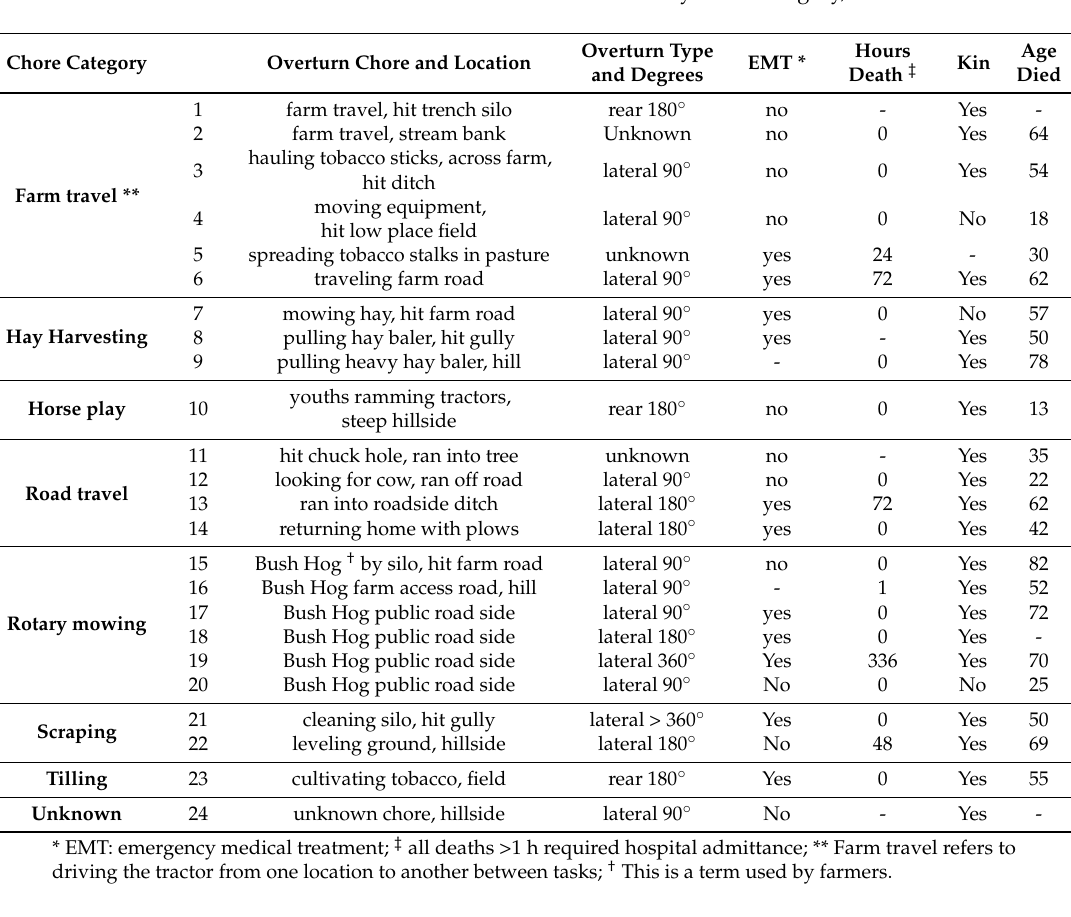
Figure 3. Chores associated with fatalities related to non-ROPS tractor overturns, n = 24. 3.2. Chores at Time of Serious Nonfatal Non-ROPS Tractor Overturns A total of 64 nonfatal operator injuries from overturns of non-ROPS tractors received EMT. For 62 individuals, 59 (95.2%) were male and three (4.8%) were female. Chore categories, as reported at the time of overturn, and other selected variables were distributed as shown in Table 5. Fifty-seven of the injured operators were family members, and three were non-family members. Space does not permit a table that tallies values for all 19 variables for which data were collected. Chore category was known for 58 cases. As shown in Figure 4, chores involved were: hay harvesting = 17; farm travel = 12; rotary mowing = 7; pulling logs, stumps; logging = 6; tillage = 4; road travel = 4; fence work = 3; applying chemicals = 3; scraping = 1; lawn mowing = 1; and unknown = 6.